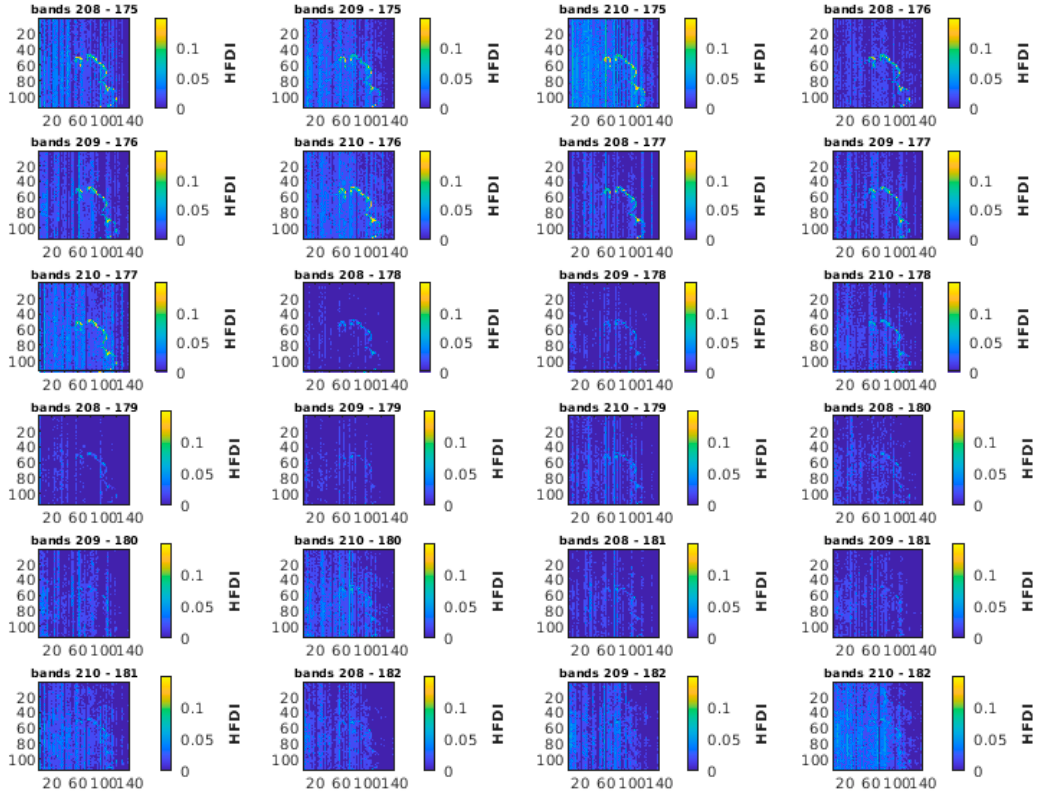
Figure 6. Hyperspectral fire detection index (HFDI) maps for the twenty-four combinations.